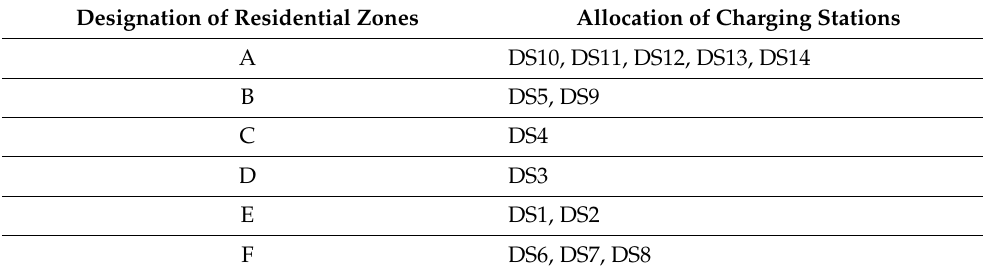
Table 18. Allocation of charging stations.